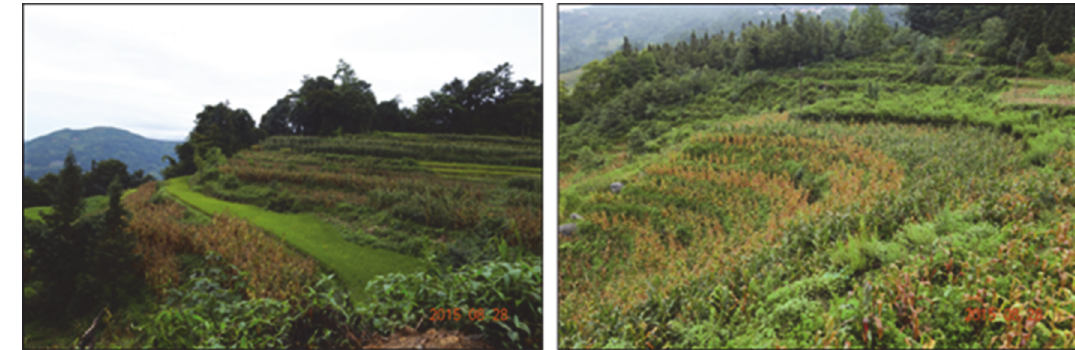
Figure 5. The rice terraces shift to land for growing corn in Gaocheng village.